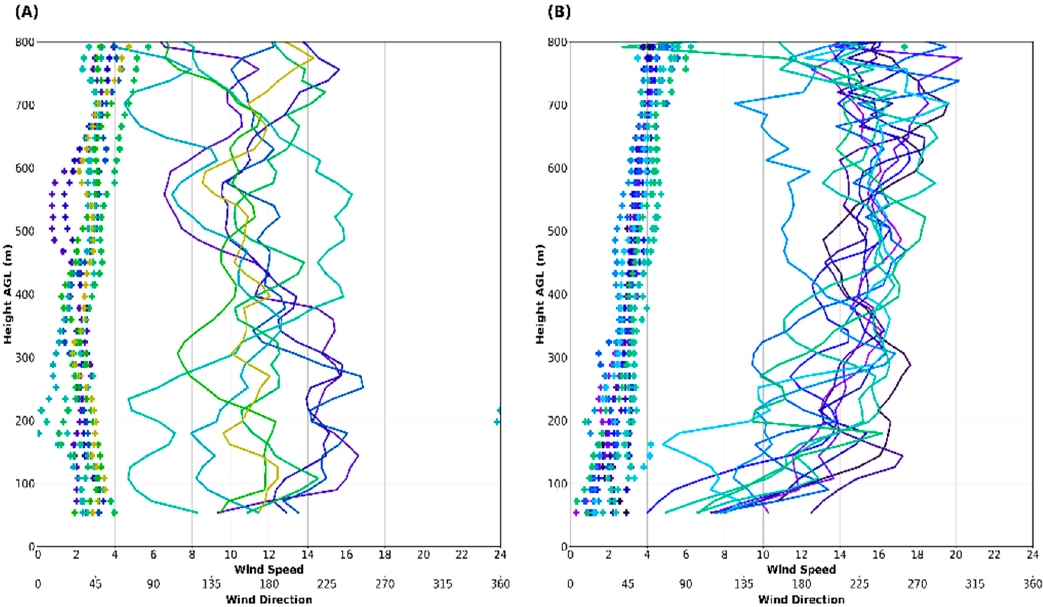
Figure 8. ( A ) Observed lidar vertical wind profiles from scan location #1 (Figure 1B). Wind speed (m s − 1 ) is represented by the solid lines with “ + ” representing the corresponding wind direction ( ◦ ). Each color represents the profile taken every 5 min between 19:00–19:40 PST 8 November 2018. ( B ) Lidar vertical wind profiles from scan location #2 (Figure 1B) with wind speed represented by the solid line with “ + ” representing associated wind direction. Each color represents the profile taken every 5 min between 21:00–22:00 PST 8 November 2018.